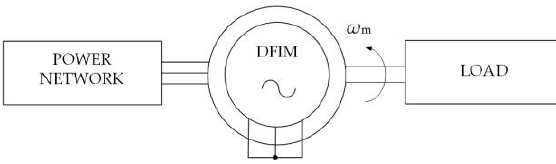
Figure 4. Schematic diagram of the modeled electromechanical system.